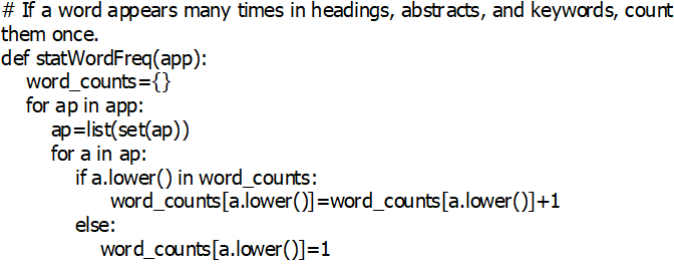
Figure A1. Pseudocode of segmenting words.